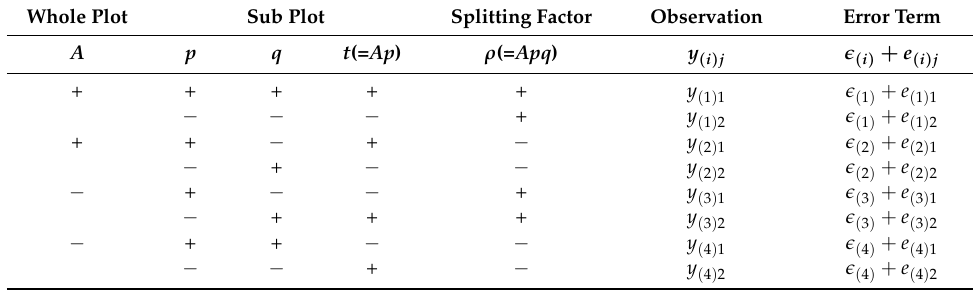
Table 6. The runs of D 2 . Whole Plot Sub Plot Splitting Factor Observation Error